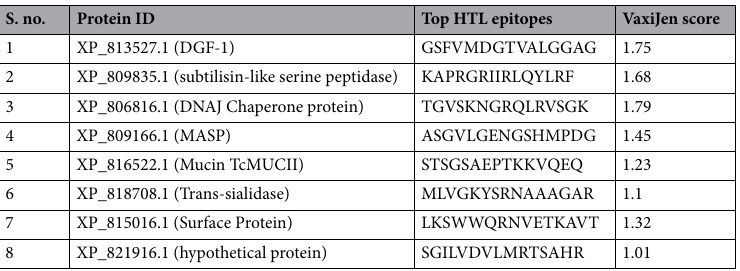
S. no. Protein ID